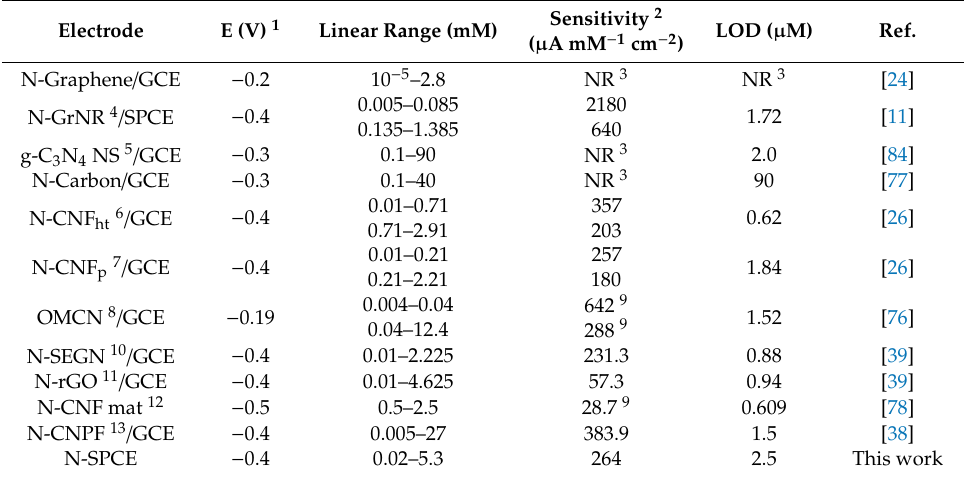
Table 2. Comparison of some N-doped carbon-based amperometric sensors for H 2 O 2